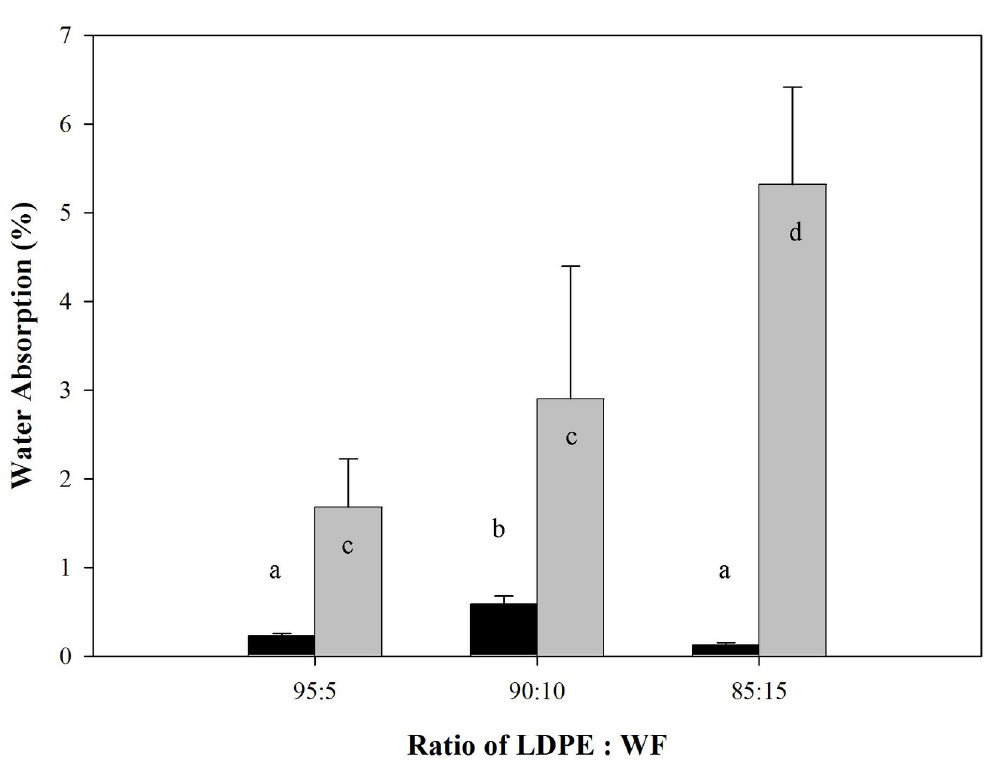
Fig 5. Water absorption of predominantly plastic WPCs (Different letter upper the bars are statistically different according to the DMRT at α = 0.05).